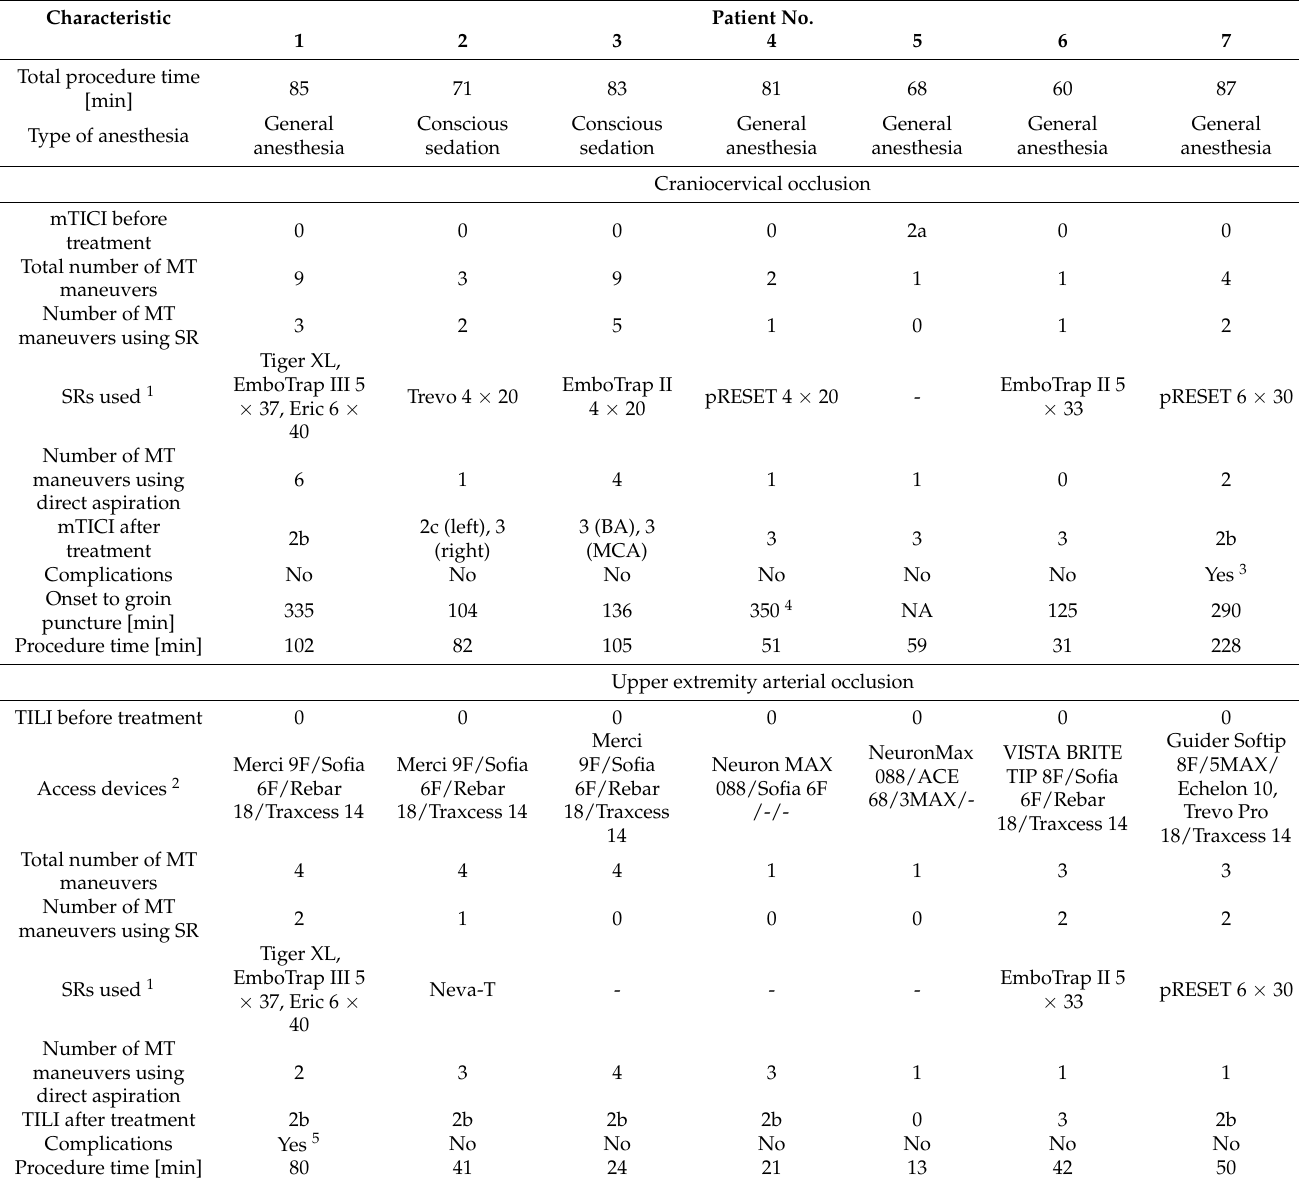
Table 2. Procedural